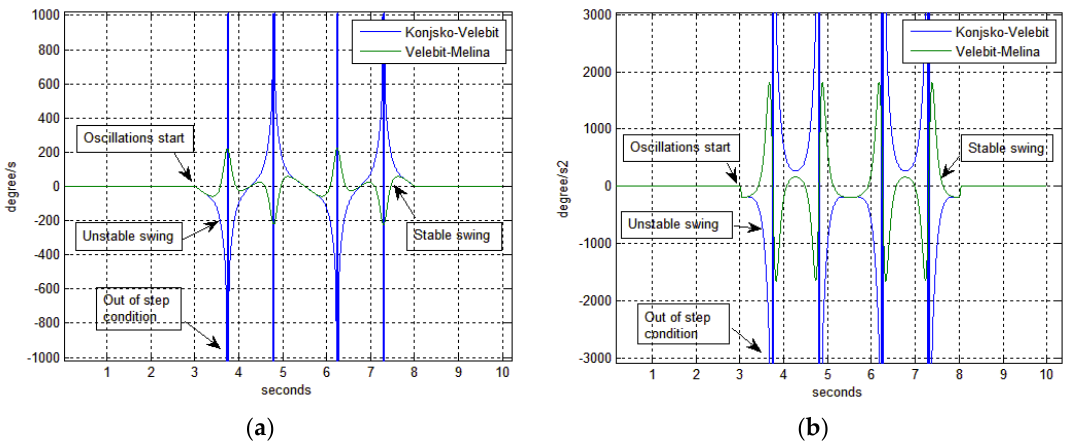
Figure 11. Out of step condition and power swing condition on 400 kV lines: ( a ) Angle speed ω , for two 400 kV transmission lines during out-of-step conditions occurrence; and, ( b ) Angle acceleration α , for two 400 kV transmission lines during out of step condition occurrence.